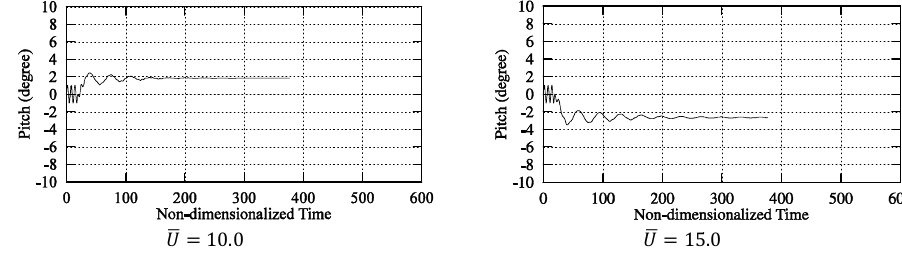
Fig. 5 Divergence bifurcation on test case II at M